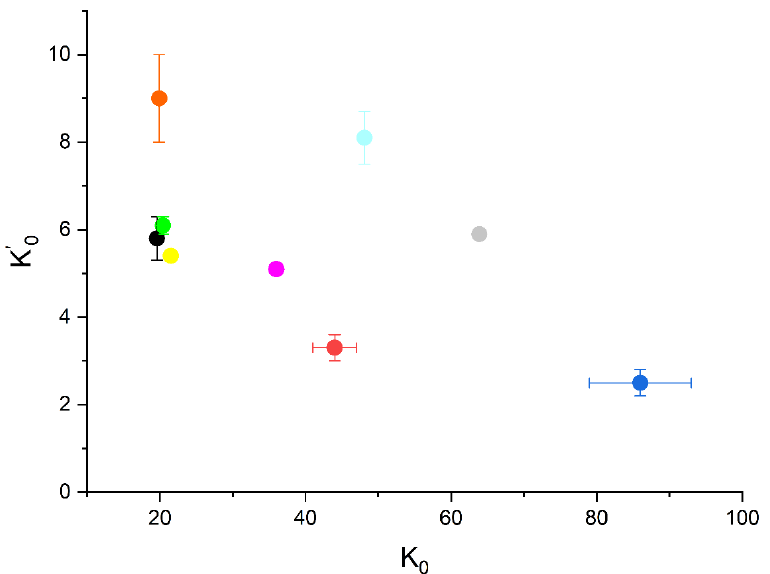
Figure 6. Comparison between bulk modulus (K 0 ) and its derivative (K’ 0 ) of some sulfate minerals reported in Table 5. Bassanite (blue), anhydrite (grey), kieserite (cyan), gypsum (red), bloedite (magenta), epsomite (yellow), meridianiite (orange), mirabilite (black), and mascagnite (green).